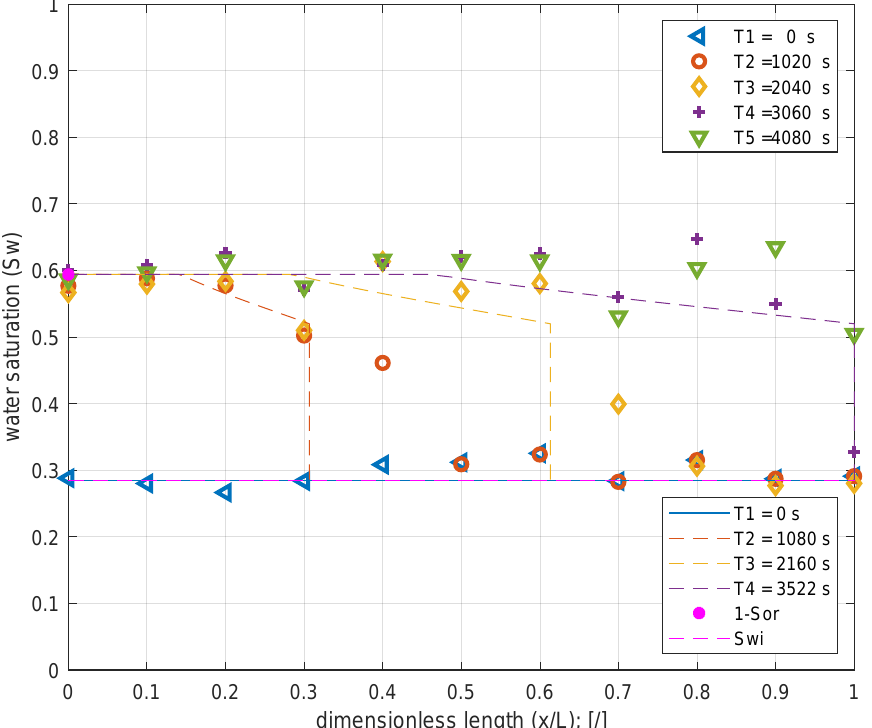
Figure 12. Comparison of the analytical and experimental frontal advance displacement graphs (M =